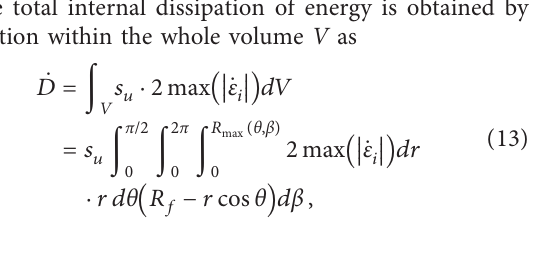
Figure 6: Layout of the derived continuous velocity field for shallow tunnel collapse ( C/D � 0.5, c D / s downward movement; (b) tunneling in upward